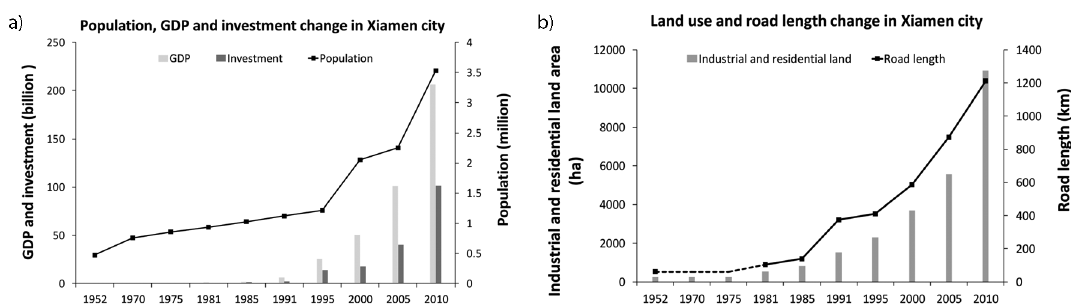
Figure 4. Background of the urbanization and industrialization change in Xiamen City (figure drawn by the